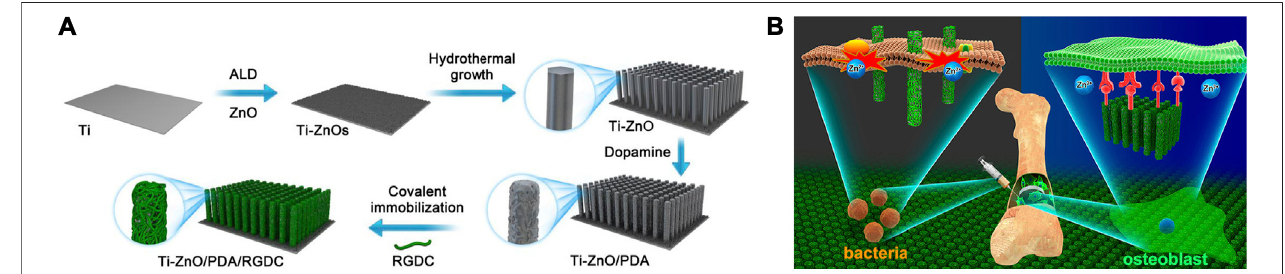
FIGURE 3 | PDA-NPs showed antioxidative and anti-in fl ammatory dual ability in the rat TMJ-OA model (Wang et al., 2021).